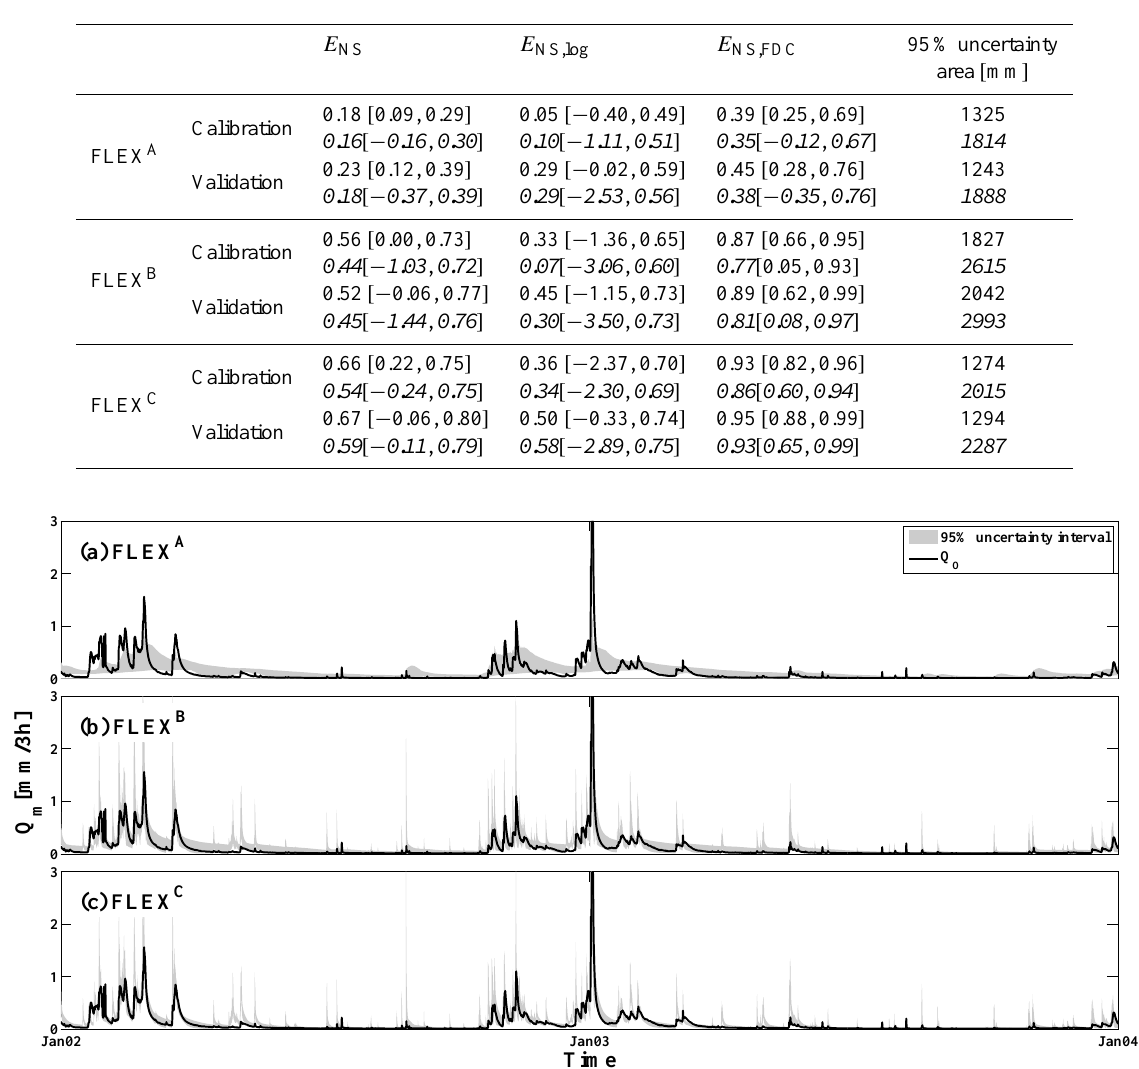
Figure 3. The observed hydrograph and the 95% uncertainty interval of the modeled hydrograph derived from the complete set of constrained but uncalibrated parameter sets for the three different model setups (a) FLEX A , (b) FLEX B and (c) FLEX C for 2 years (2002–2003) of